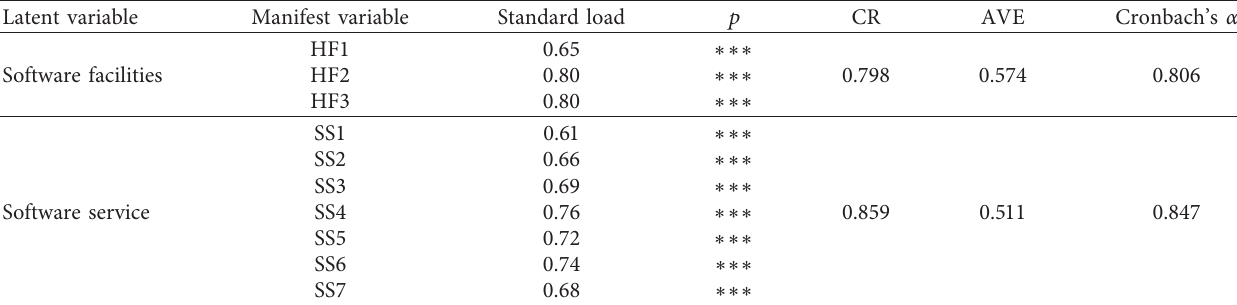
Table 5: Results of reliability analysis and validity analysis.